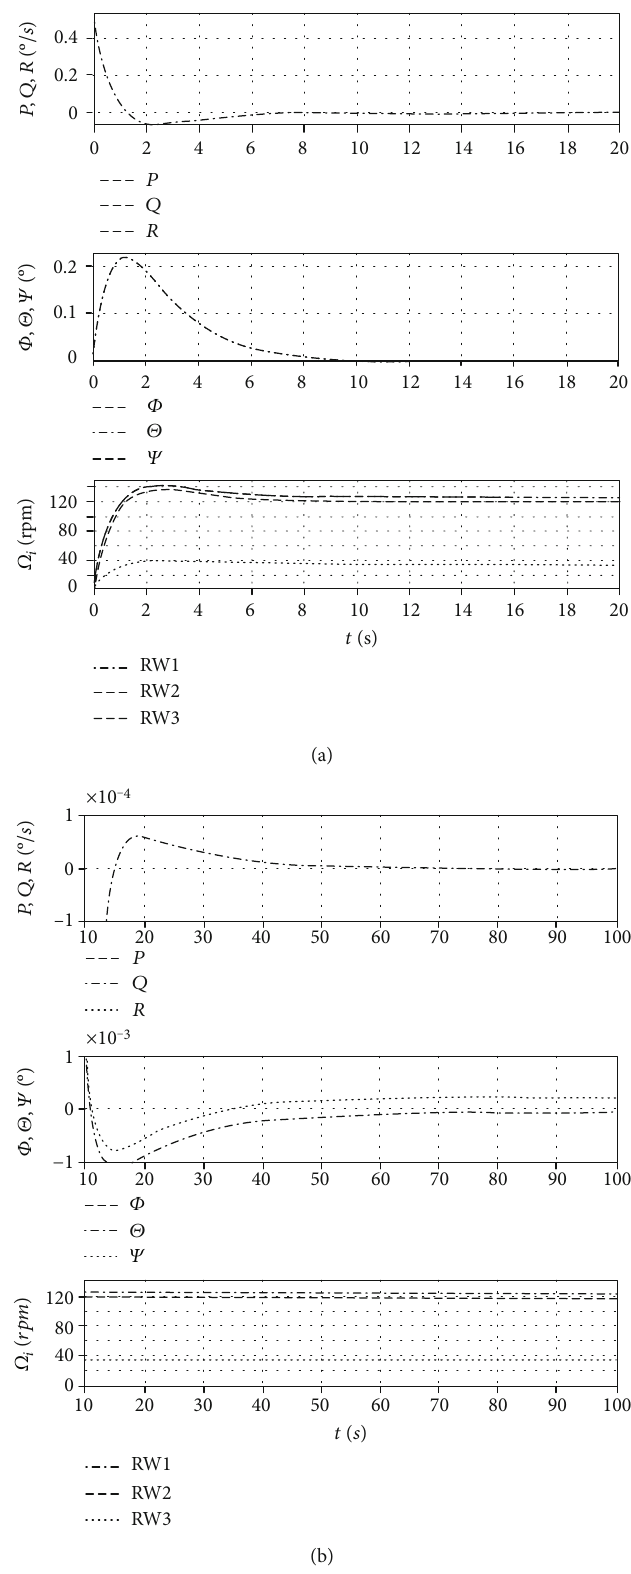
Figure 7: (a) Stabilization in the nominal mode, case 1; (b)